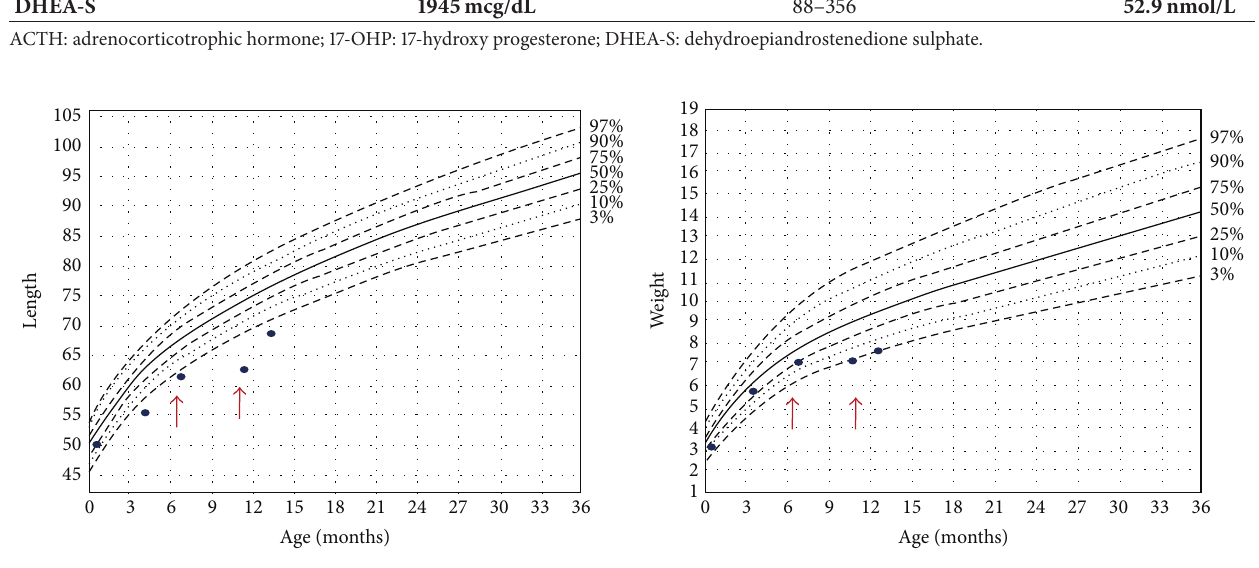
Figure 4: Growth retardation was occurring especially between 7th and 11th